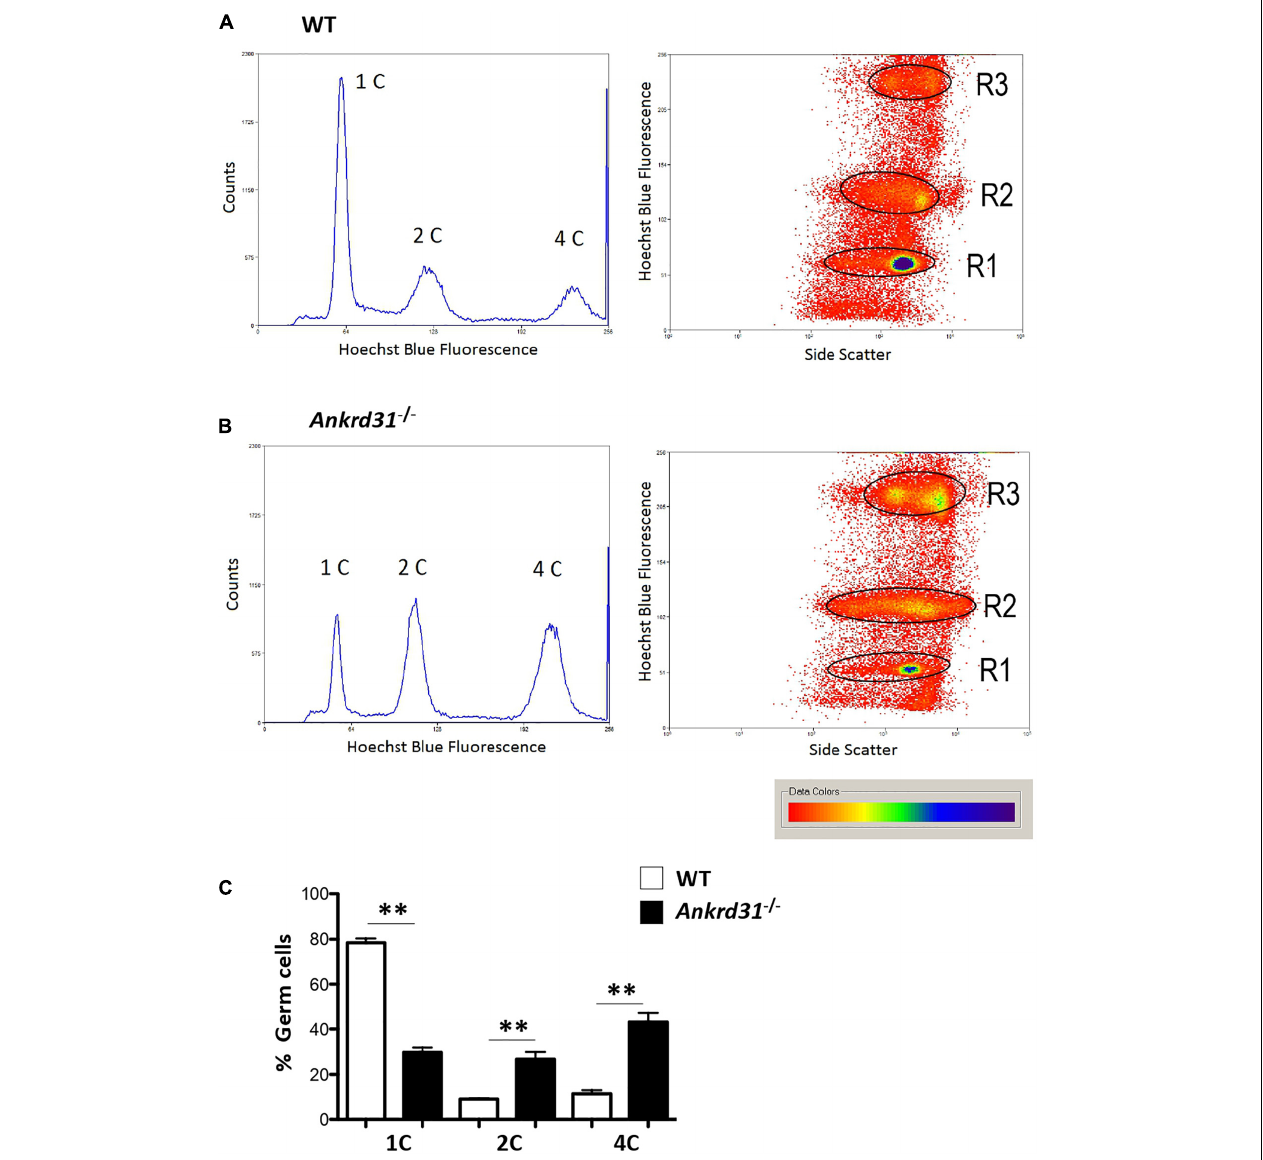
FIGURE 3 | Representative histograms and density plot showing the distribution of testicular germ cell populations, based on their DNA content, in WT and Ankrd31 − / − by flow cytometry. (A) FACS analysis of isolated WT male germ cells. (B) FACS analysis of isolated Ankrd31 − / − male germ cells. (C) Quantification analysis between WT and Ankrd31 − / − germ cell subpopulations isolated from n = 6 animals/each genotype. Data are expressed as percentage (%) of germ cells and reported as mean ± SEM, ** p < 0.01.